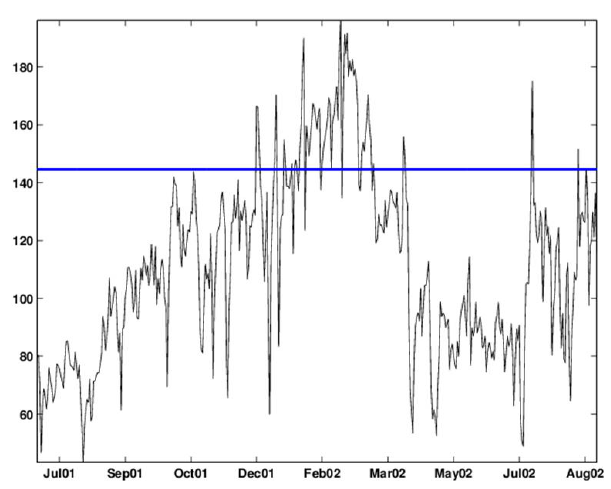
Figure 11. EWMA chart with λ = 0 . 4 and an upper 2.33-sigma limit applied to the deseasonalized data. The chart signals alarms on: December 15–17 and 29–30, 2001, and January 5–6, 11 and 13–14, 2002; most days between January 17, 2002 and March 14, 2002; and April, 6–7, 2002 and July 13, 2002, and